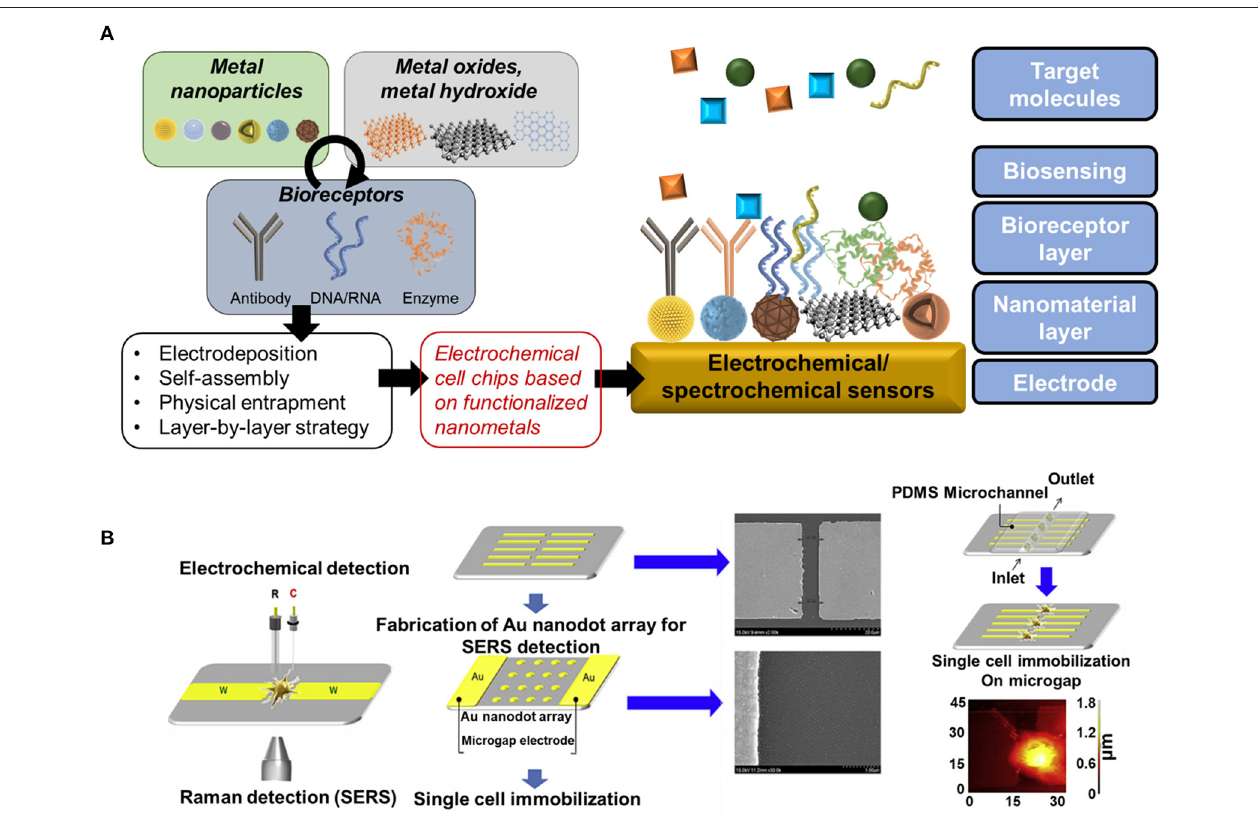
FIGURE 1 | (A) Schematic diagram of main components and representative strategies for development of nanomaterials-based electrochemical biosensor and (B) Schematic diagram of the immobilization of a single cell on a microgap between pairs of Au microelectrodes. Reproduced with permission from El-Said et al., 2015b (Copyright © 2015